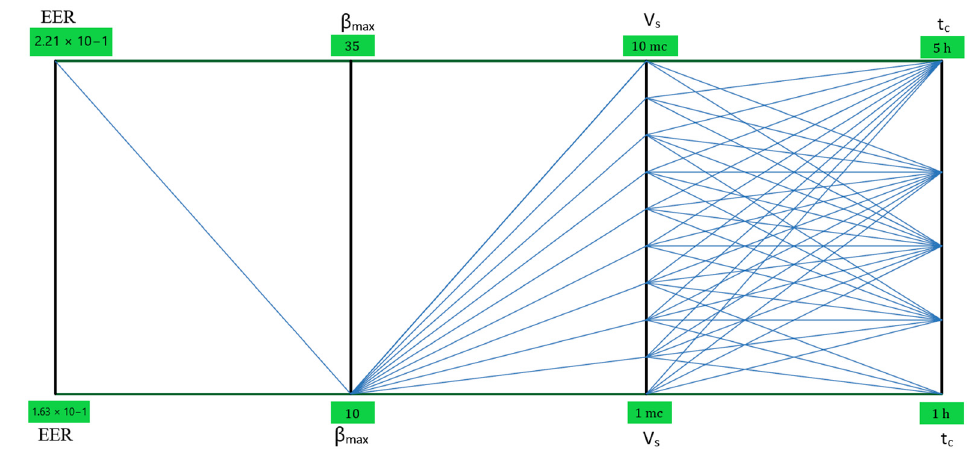
Figure 8. Parallel coordinate chart of the EER output variable in the optimized case.